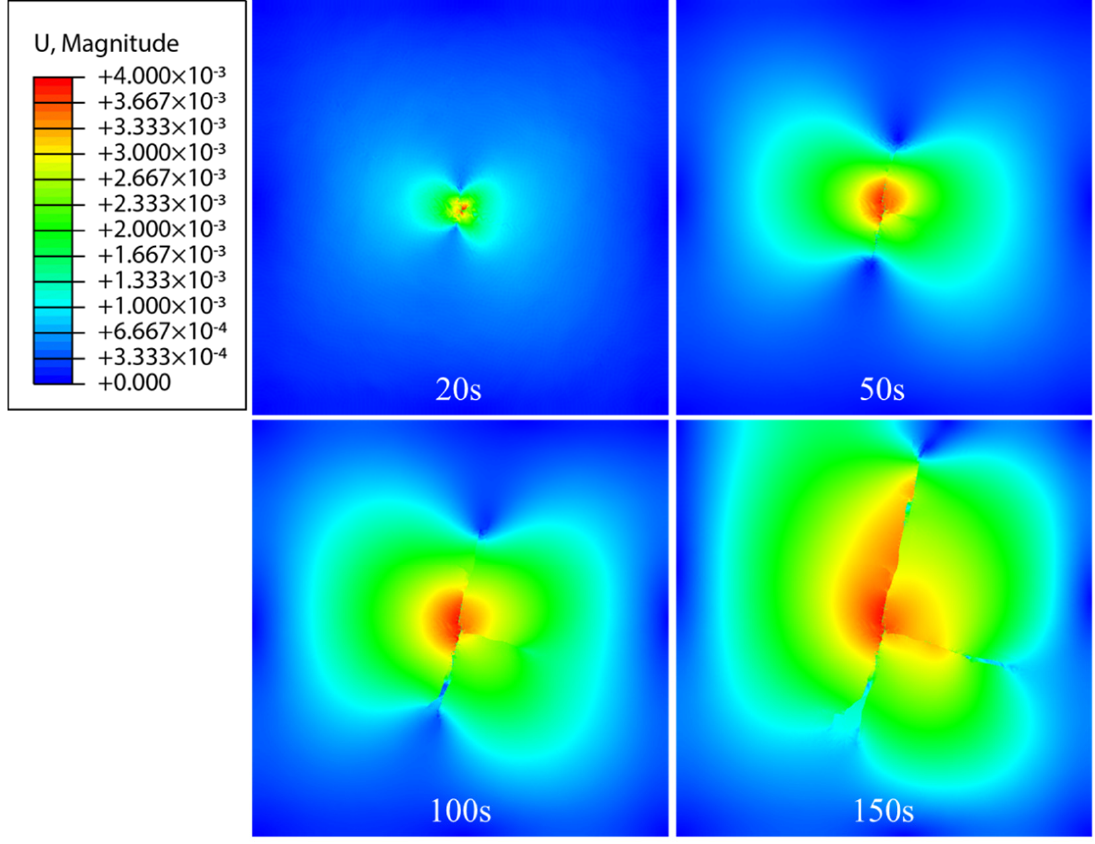
Figure 4. Pore pressure of the injection point in the natural fracture network of group A.